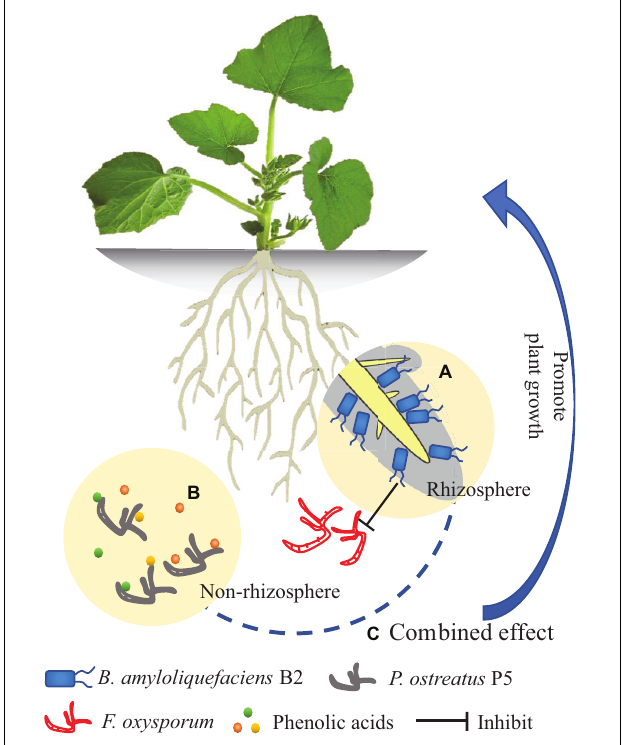
FIGURE 10 | Model diagram of the effect of Bacillus amyloliquefaciens B2 and Pleurotus ostreatus P5 on plant growth. (A) B. amyloliquefaciens B2 can inhibit the Fusarium oxysporum in rhizosphere soil. (B) P. ostreatus P5 can biodegrade the phenolic acids in non-rhizosphere soil. (C) The combination of B. amyloliquefaciens B2 and P. ostreatus P5 synergistically enhances plant